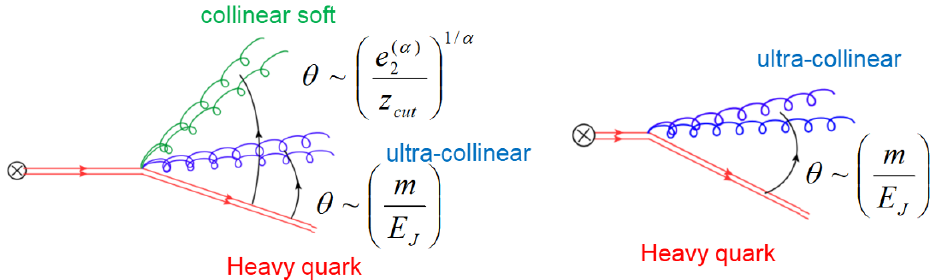
Figure 3 . Hierarchy of scales in factorization. The horizontal axis indicates the size of e ( (cid:11) ) (increasing right to left) while the vertical axis shows increasing virtuality of the relevant modes in each region. See section 3.2 for descriptions of the regions and the applicable factorizations.